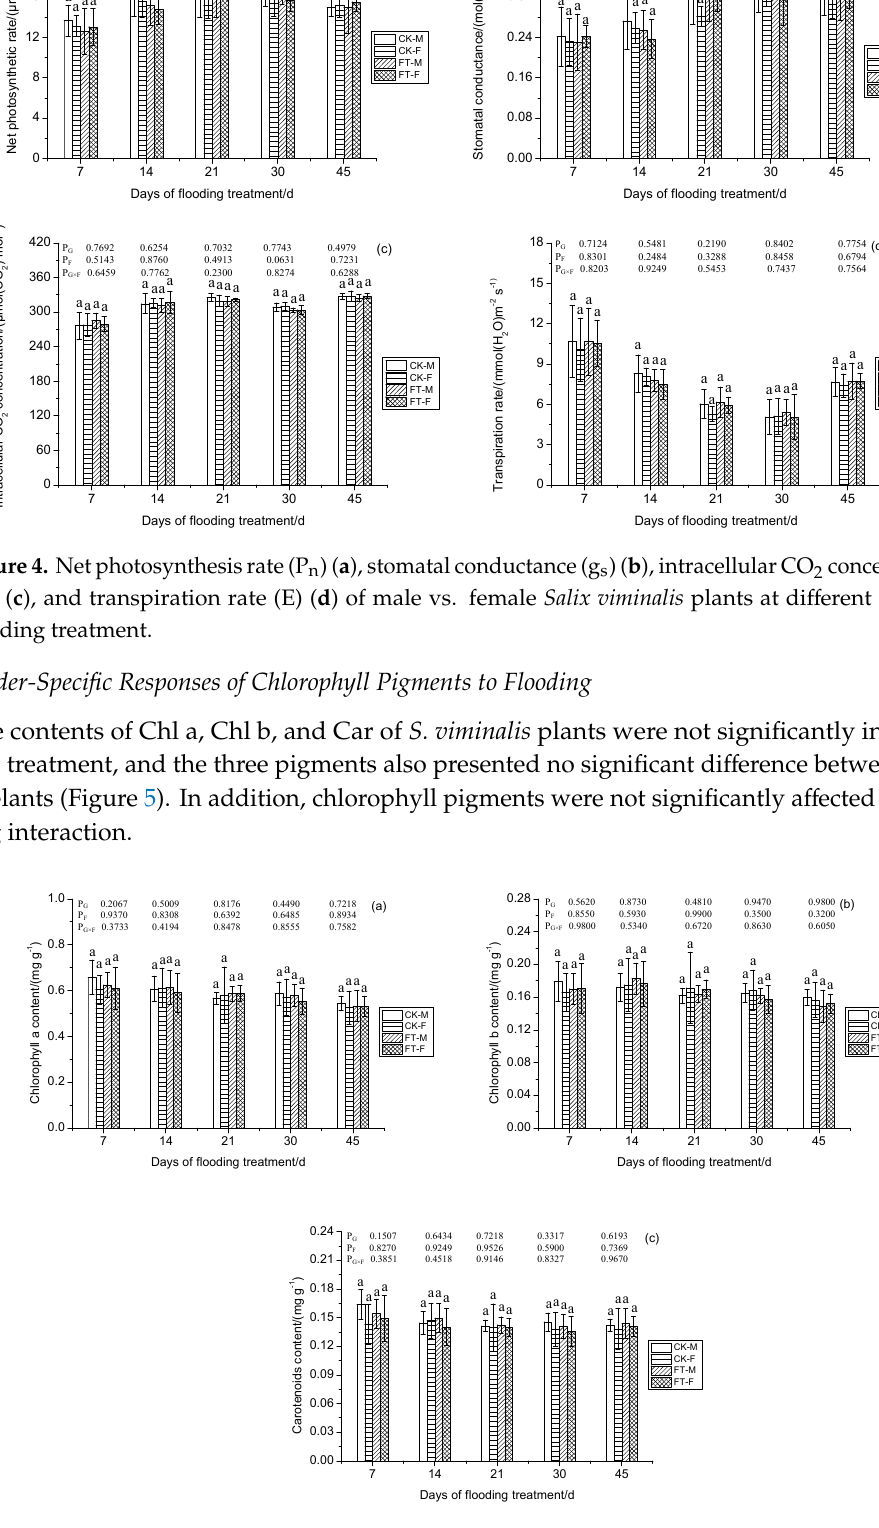
parenchyma and transversal vascular bundles, etc. (Figure 3). After flooding treatment for 45 days,